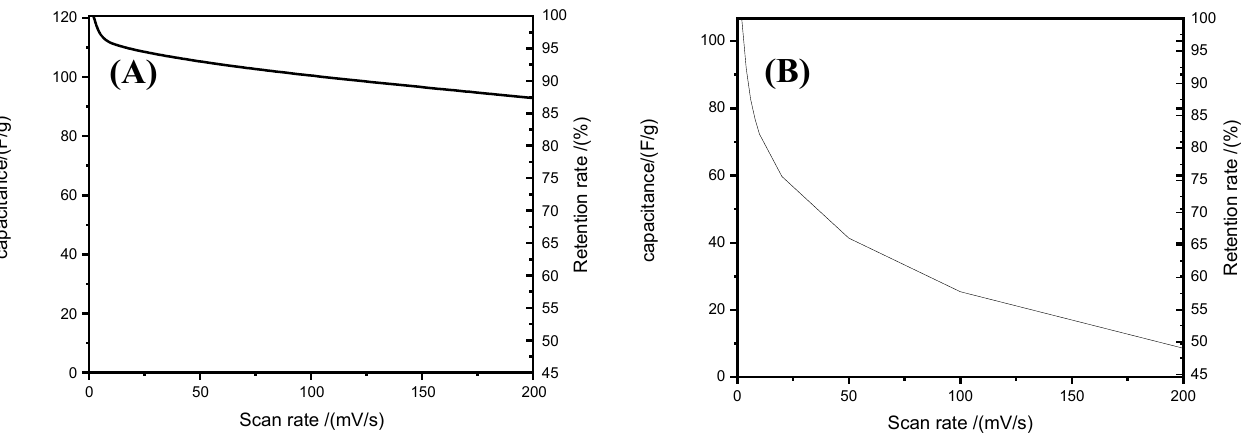
Figure 10. Specific capacitance and capacitance retention vs. scan rate for ( A ) hot-pressed BI-PI capacitor and ( B ) commercial TF-4030 cellulose capacitor.